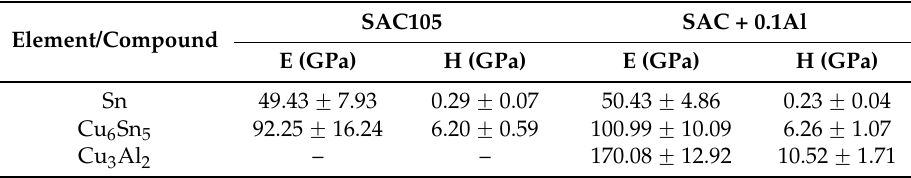
Table 2. Hardness and modulus of Pure Sn, Cu 6 Sn 5 , and Cu 3 Al 2